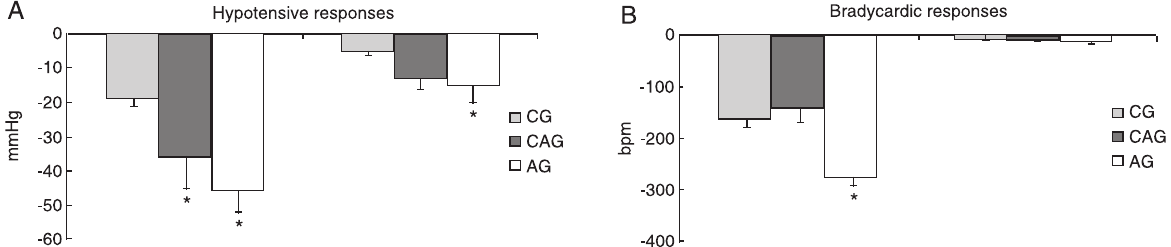
Figure 2. A , Mean hypotensive response obtained with all doses of serotonin before and after atropine administration; B , mean brady- cardic response obtained with all doses of serotonin before and after atropine administration for the control group (CG), carotid group (CAG) and aortic group (AG). *P < 0.05 versus CG (two-way